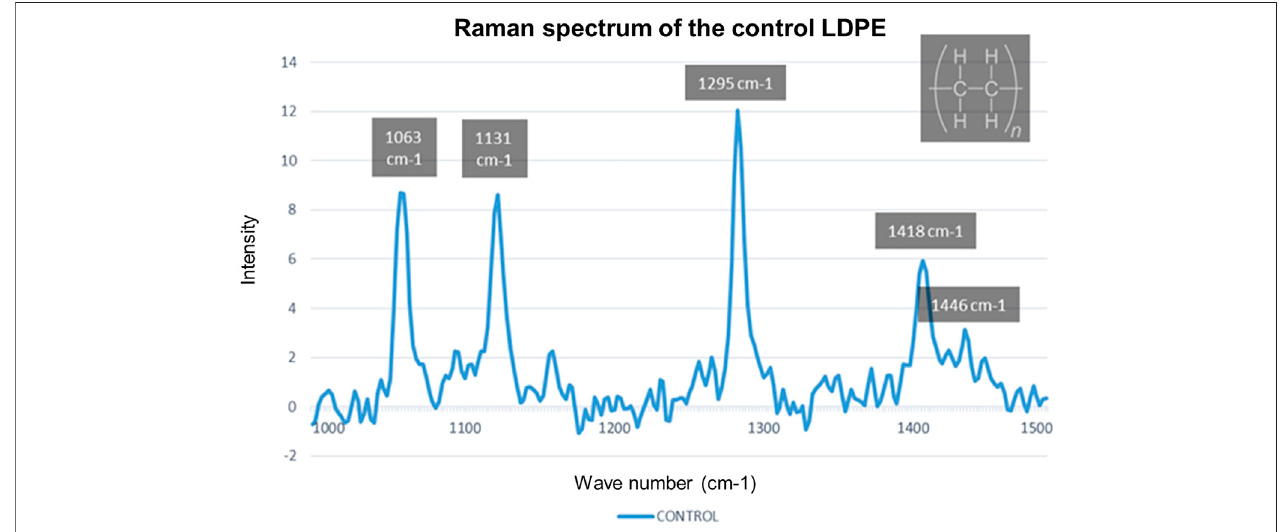
FIGURE 5 | Raman spectrum of the control LDPE.